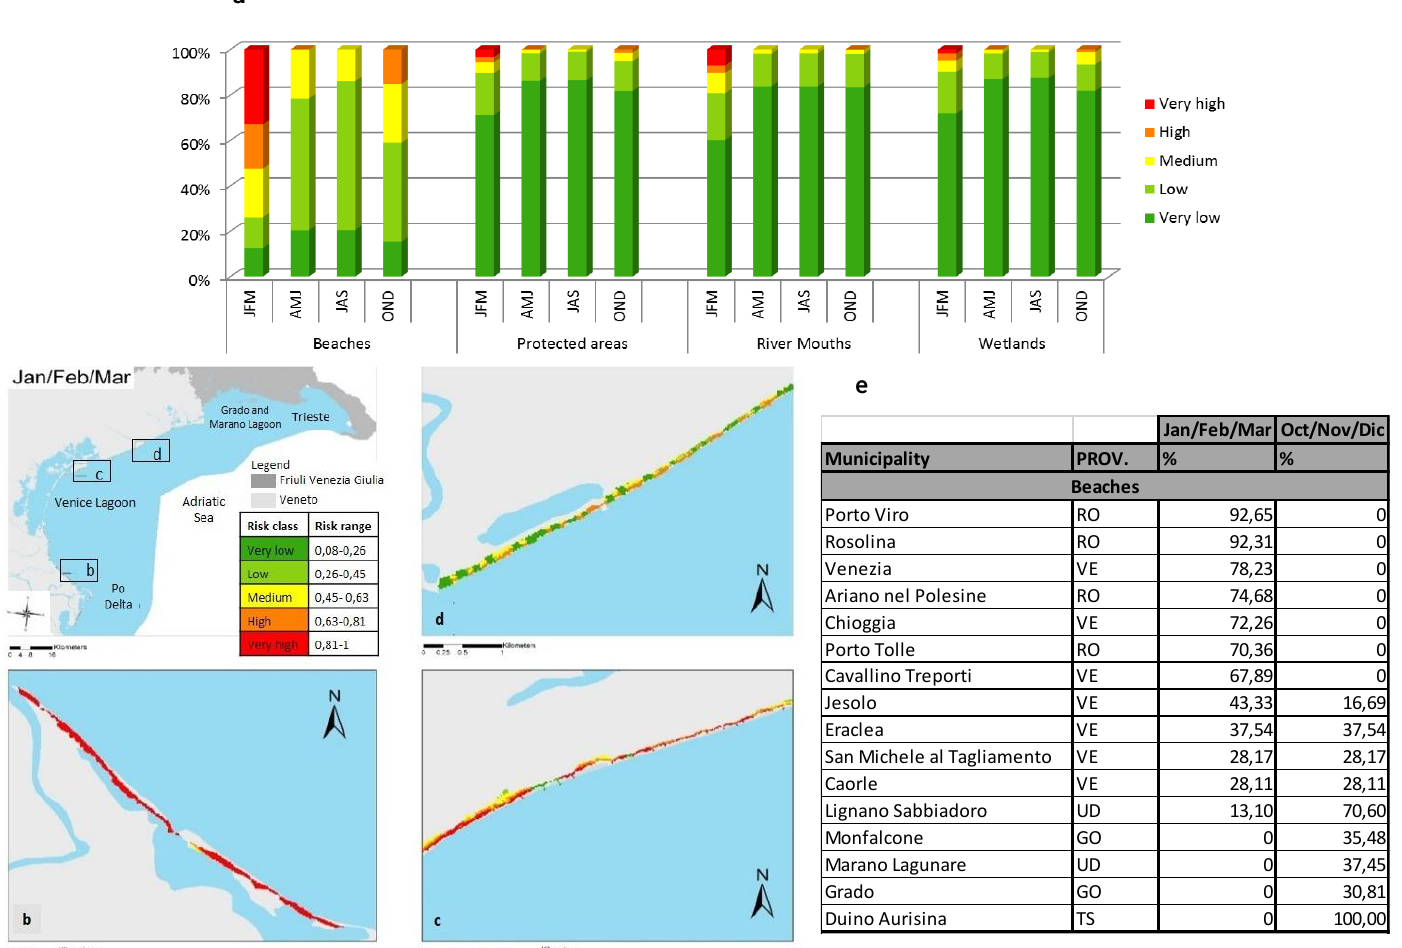
Figure 4. Percentage of receptors’ surface in each risk class for the 4 seasons (January-February-March JFM; April-May-June AMJ; July-August-September JAS; October-November-December OND) of the future scenario 2070 – 2100 ( a ); example of risk map for beaches in the trimester Jan/Feb/Mar ( b – d ); percentage of beach surface in the higher risk classes for the coastal municipalities in the NA study area ( e ).